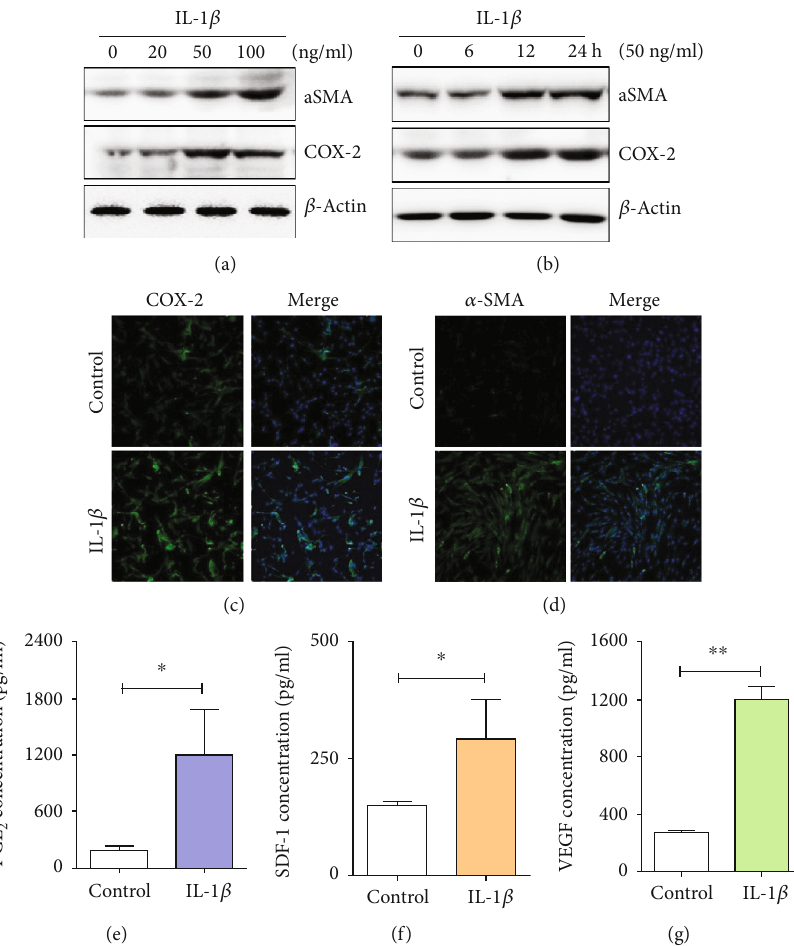
Figure 1: The e ff ect of IL-1 β pretreatment on ADMSC activation. (a) Expressions of α -SMA and COX-2 were upregulated at a dose- dependent manner when ADMSCs were treated with di ff erent concentrations of IL-1 β (0, 20, 50, and 100ng/ml) for 12hr. (b) Expressions of α -SMA and COX-2 were upregulated at a time-dependent manner when ADMSCs were treated with 50ng/ml IL-1 β for di ff erent times (0, 6, 12, and 24hrs). (c, d) Immuno fl uorescence staining indicated that IL-1 β (50 ng/ml) treatment increased the expression of α -SMA and COX-2 in ADMSCs. (e – g) IL-1 β treatment increased the secretion of PGE ∗∗ P < 0 : 01 , Student ’ s t